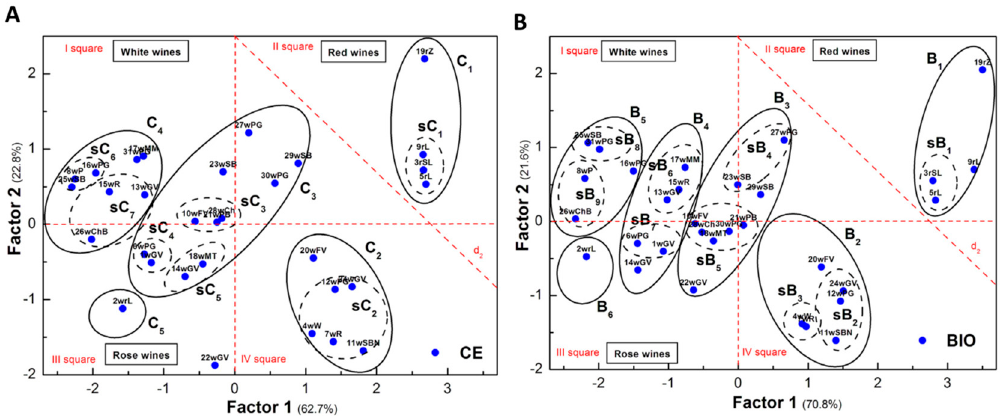
Figure 5. Principal component analysis evaluation of wine samples based on the capillary electrophoresis (CE) ( A ) and biosensor (BIO) analysis of the carboxylic acids ( B ). Reproduced from [46] by permission.